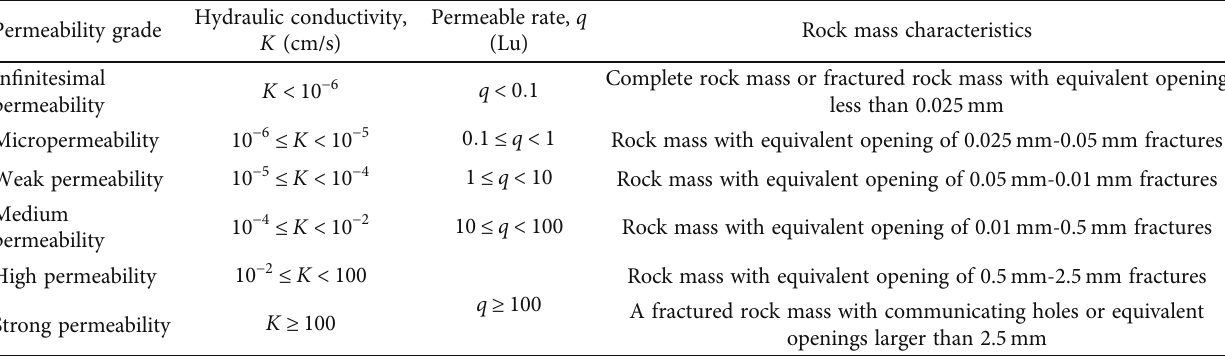
Table 2: Classi fi cation standard for permeability of rock and